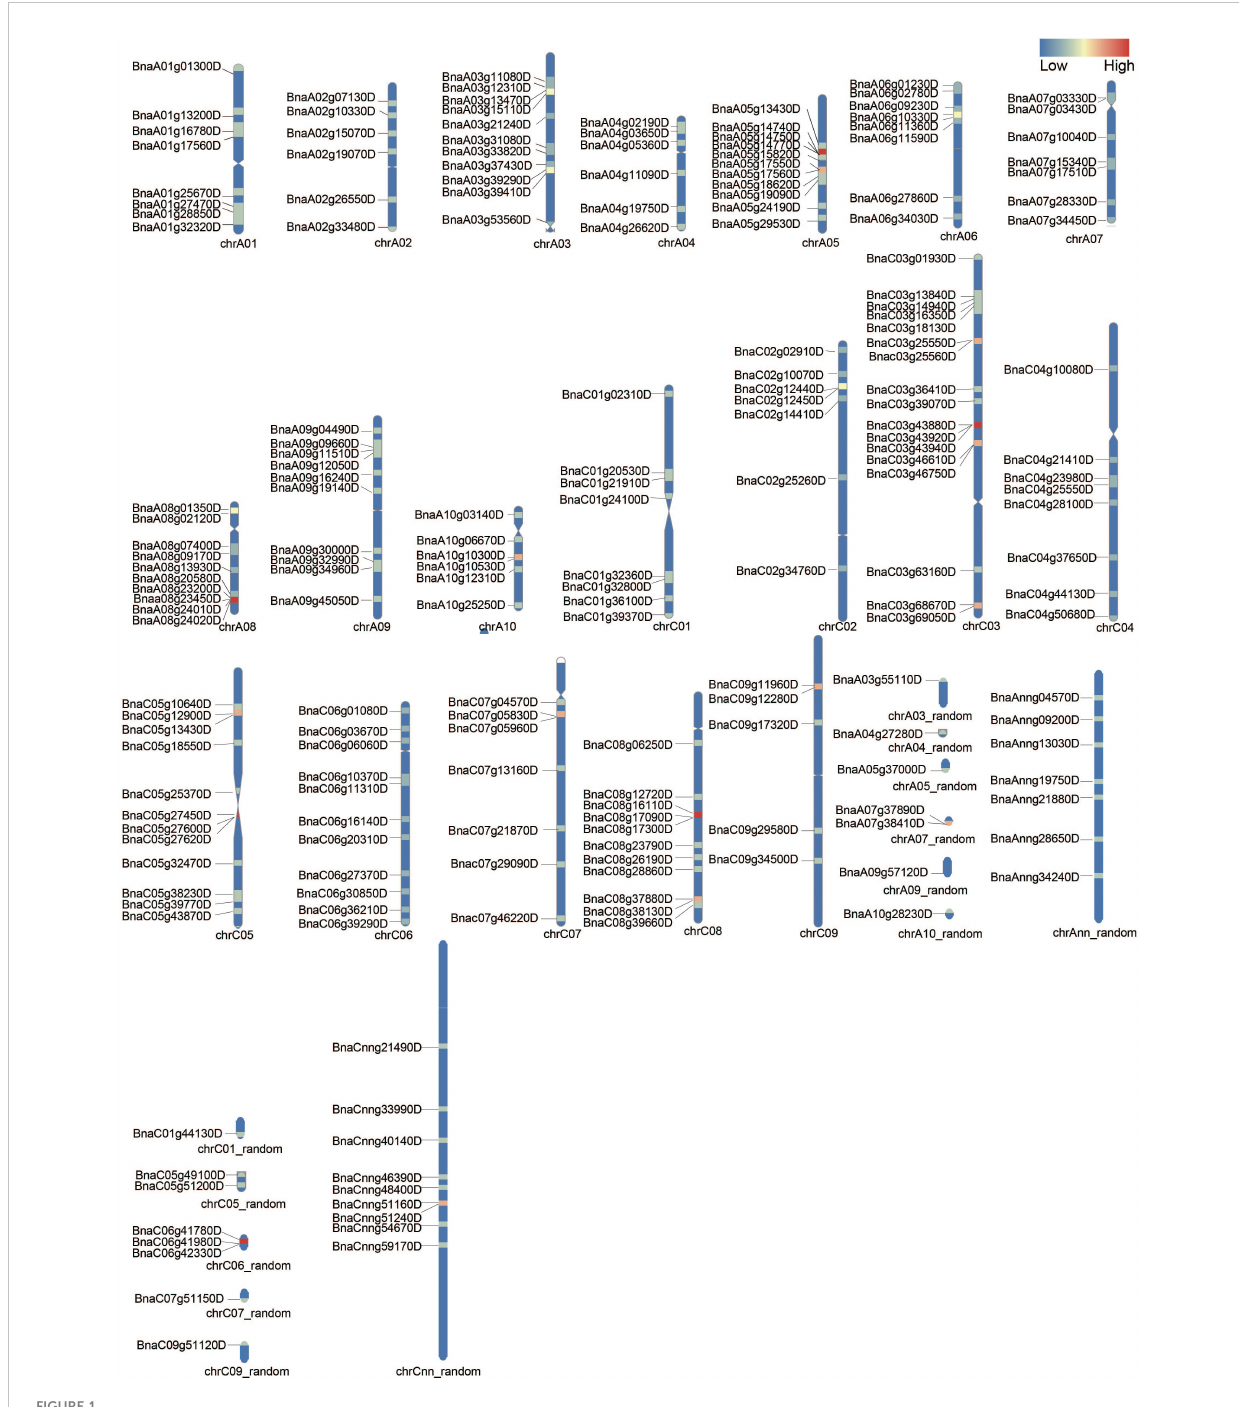
FIGURE 1 Chromosomal distribution of BnUBC s. The BnUBCs ’ genome locations are plotted based on the location of genes, length of chromosomes, and positions of centromeres. The chromosome name is marked at the bottom of each bar. Heatmap represents the gene density (number of genes per Mb) of each